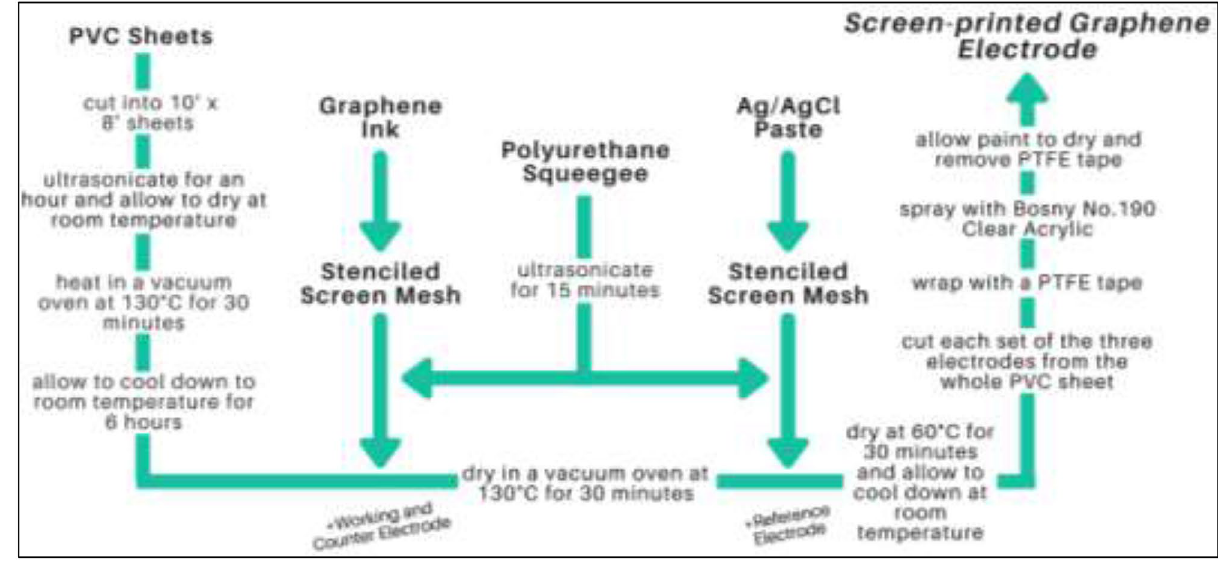
Figure 1. Schematic diagram of the SPGE